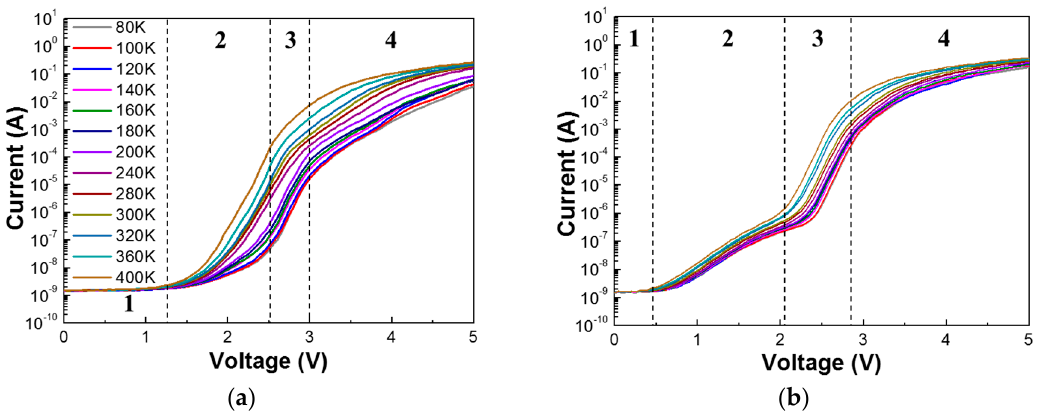
Figure 1. Temperature-dependent current–voltage ( T-I-V) characteristics of ( a ) LED I and ( b ) LED II under forward bias from 80 K to 400 K.